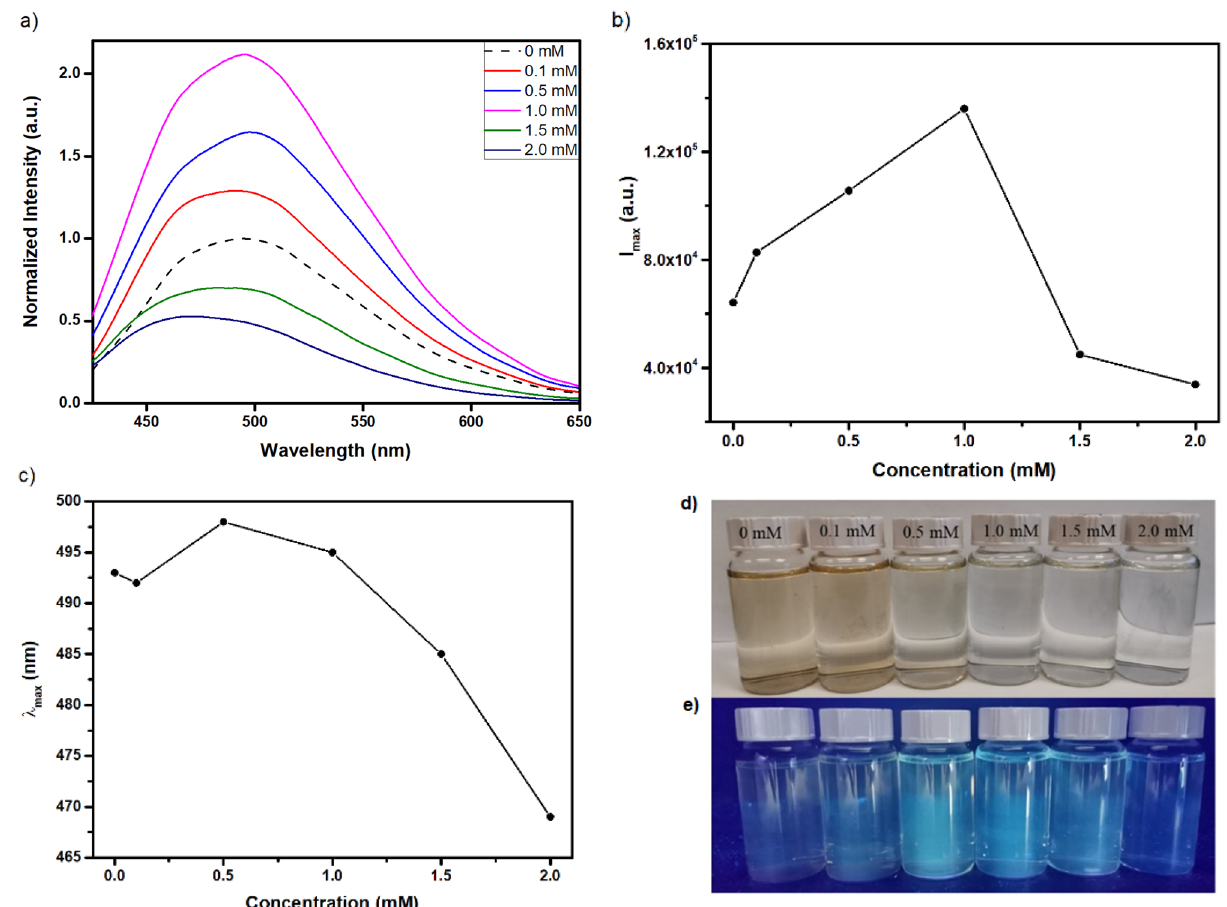
Figure 4. 0.02 mg ml –1 C-dots dispersed in aqueous solution of NaClO with salt concentrations 0.1, 0.5, 1.0, 1.5 and 2.0 mM, compared to the untreated sample. ( a ) PL spectra (λ ex = 410 nm), ( b ) the corresponding maximum PL intensity (I max ) and ( c ) λ max as a function of the electrolyte concentration, photos of C-dots dispersions under daylight ( d ) and ( e ) UV radiation. All data have been collected 48 h after the dispersion of C-dots in the aqueous solution of